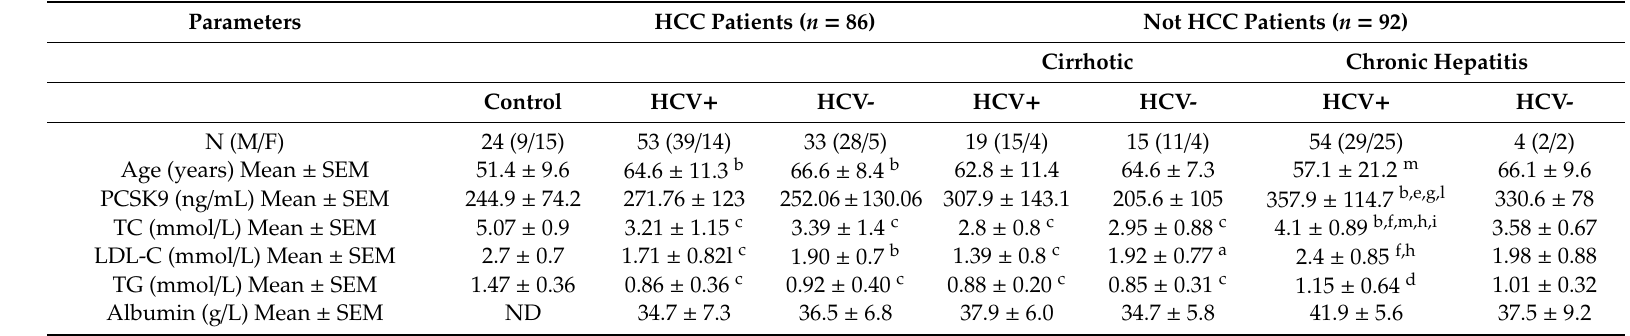
Table 1. Anthropometric and biochemical parameters of recruited patients. HCC: Hepatocellular carcinoma; HCV: Hepatitis C virus; BMI: Body mass index; TC: Total cholesterol; LDL-C: Low-density lipoprotein cholesterol; TG: Triglycerides. SEM: Standard error of the mean. ND: Not determined. a p < 0.05 vs. control; b p < 0.01 vs. control; c p < 0.001 vs. control; d p < 0.05 vs. HCC HCV + ; e p < 0.01 vs. HCC HCV + ; f p < 0.001 vs. HCC HCV + ; g p < 0.01 vs. HCC HCV-; h p < 0.001 vs.